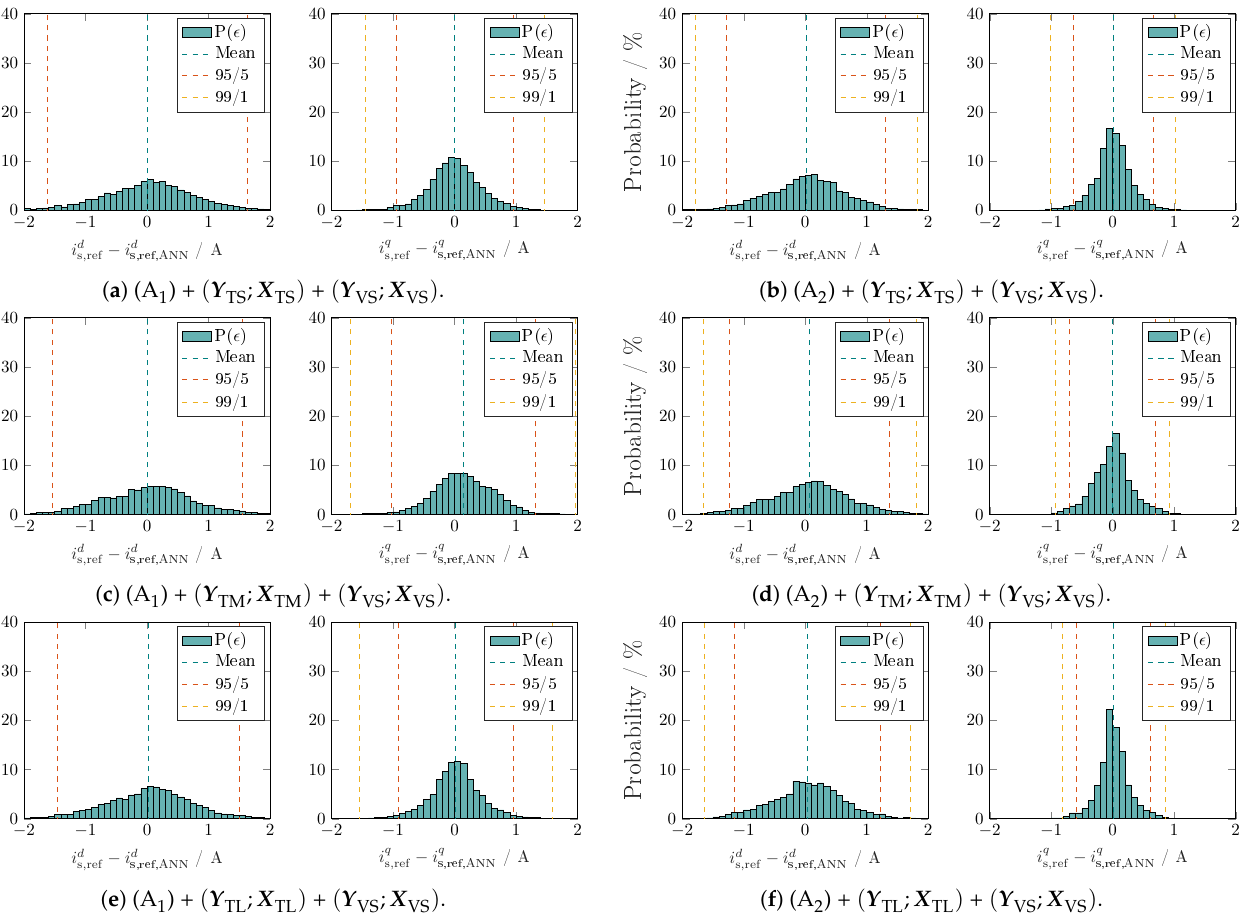
d s,ref − i s,ref,ANN [left subplots] and